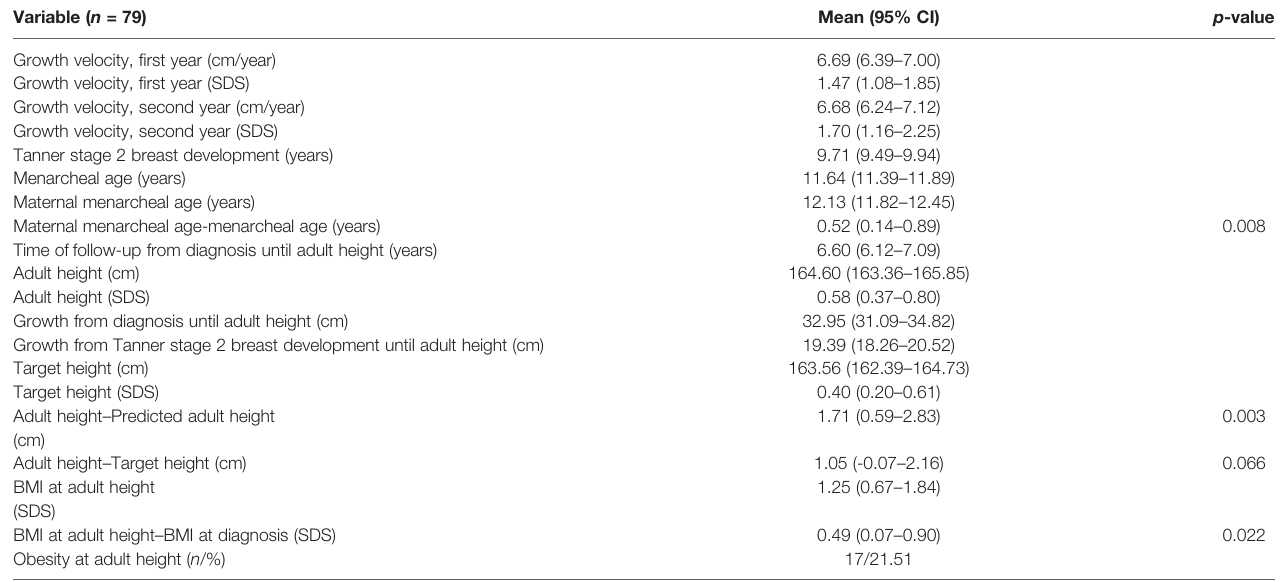
TABLE 2 | Clinical follow-up of girls with IPA. Variable ( n =